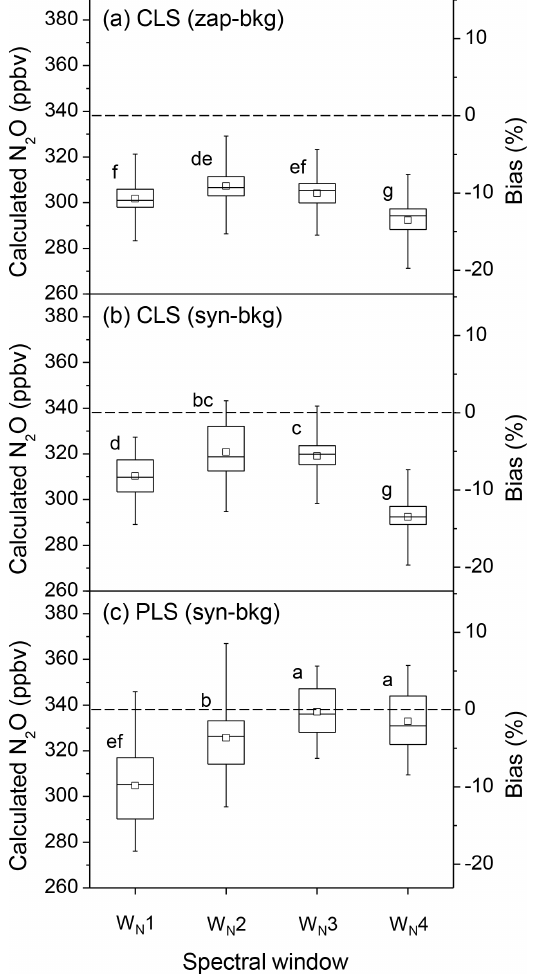
Figure 5. The box plots of the calculated N 2 O concentrations and the corresponding biases from a series of OP-FTIR spectra ( n = 90) that contain 338 ± 0 . 3ppbv N 2 O with varying humidity and air temperature using different SB background-processing meth- ods (zap-bkg and syn-bkg) and four spectral windows ( W N 1–4) in the CLS and PLS models: (a) zap-bkg + CLS model, (b) syn- bkg + CLS model, and (c) syn-bkg + PLS model. The plot displays the mean ( (cid:3) ), median (–), interquartile ranges (box), and extreme values (whiskers). Different letters indicate significant differences ( p <0.05) among the means calculated by different quantitative methods by the least significant difference (LSD).